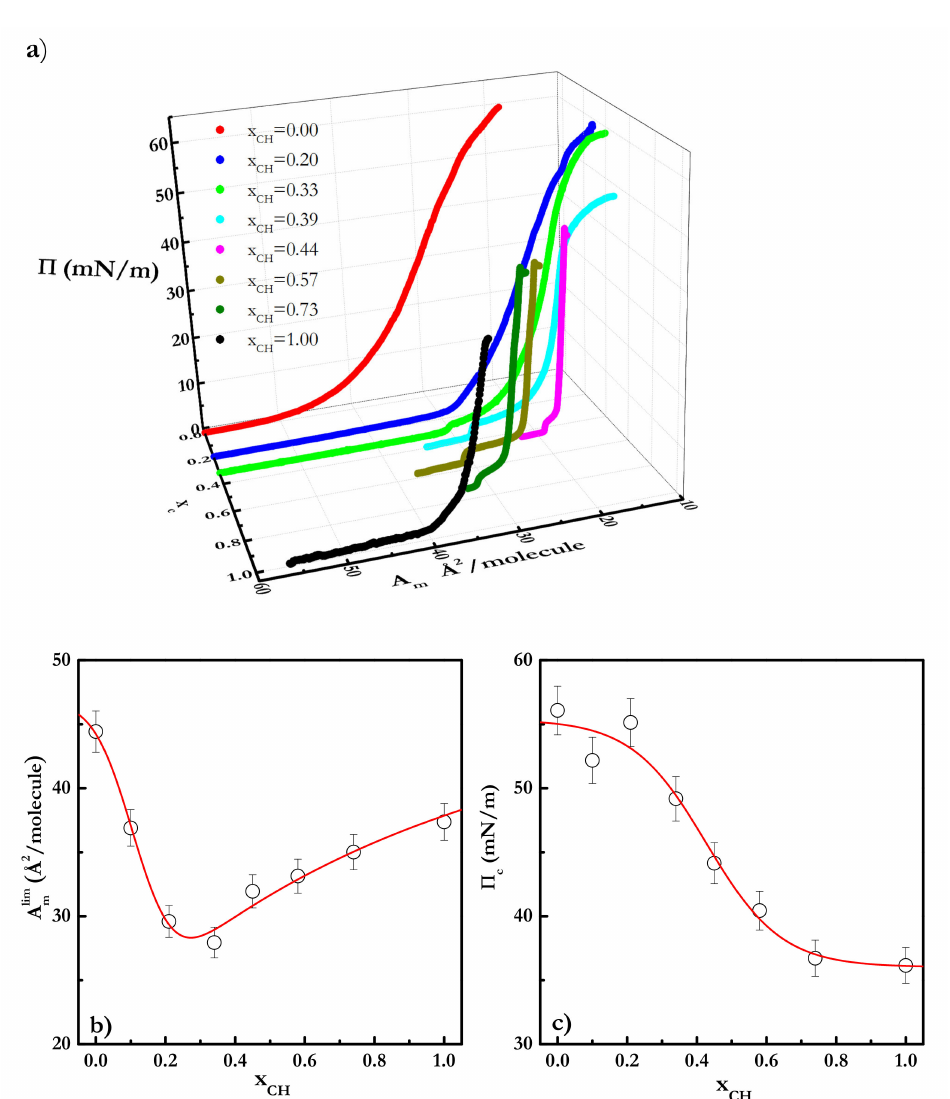
Figure 7. ( a ) Selected surface pressure-area per molecule isotherms for Langmuir monolayers of mixtures of CH and CE with different x CH spread at the water/vapor interface at 35 ◦ C. ( b ) Dependence of the limiting area per molecule on x CH for Langmuir monolayers of mixtures of CH and CE spread at the water/vapor interface at 35 ◦ C. ( c ) Dependence of the collapse pressure on x CH for Langmuir monolayers of mixtures of CH and CE spread at the water/vapor interface at 35 ◦ C. The solid lines in panel ( b , c ) are guides for the